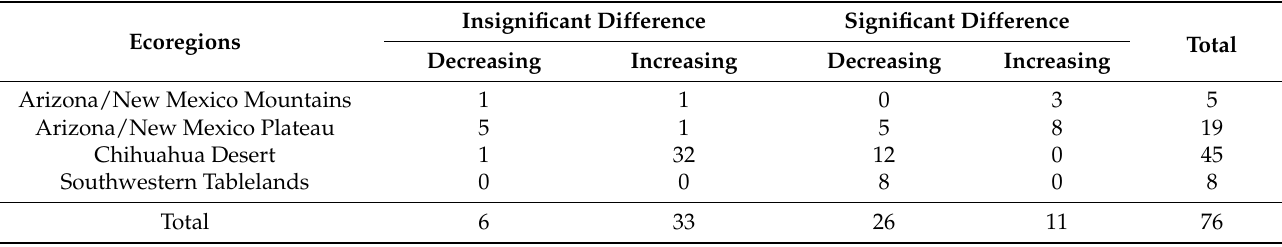
Table A4. The percentages of the randomly selected shrublands pixels with respect to their significance in the difference in mean productivity before and after the break years based on the RPMS data along with their identified direction of change over the major ecoregions in New